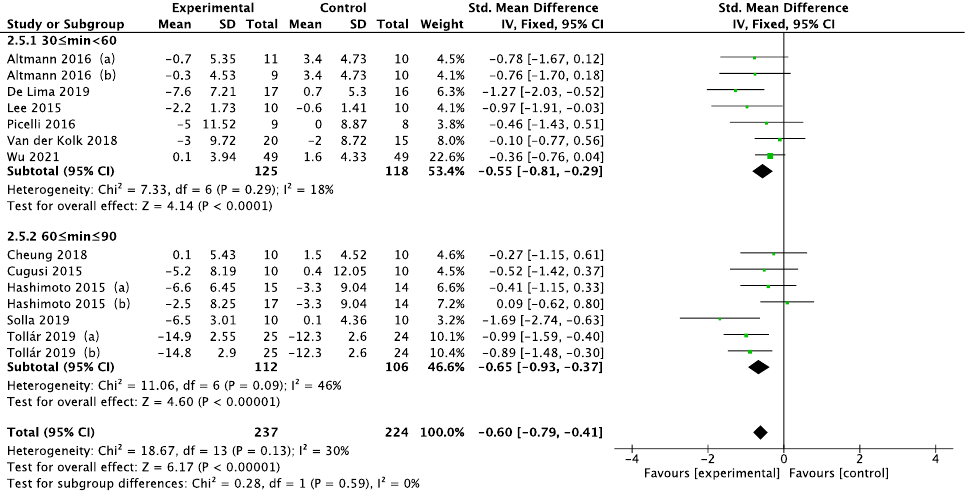
Table 2. Regression analysis of covariate for PD patients with depression.